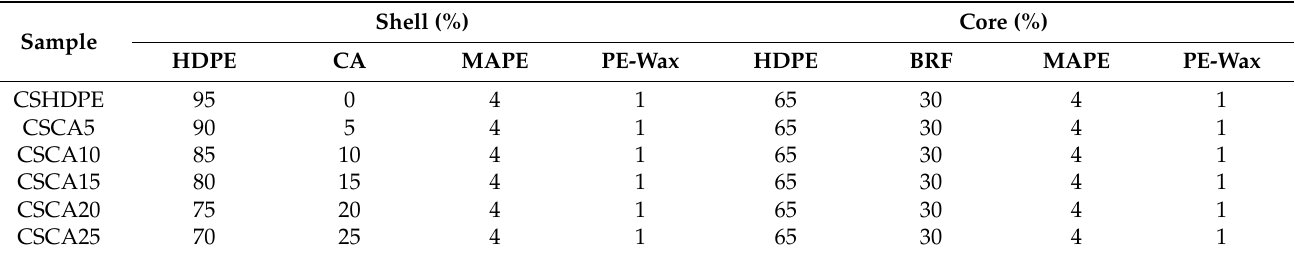
Table 2. The composition of core–shell structured